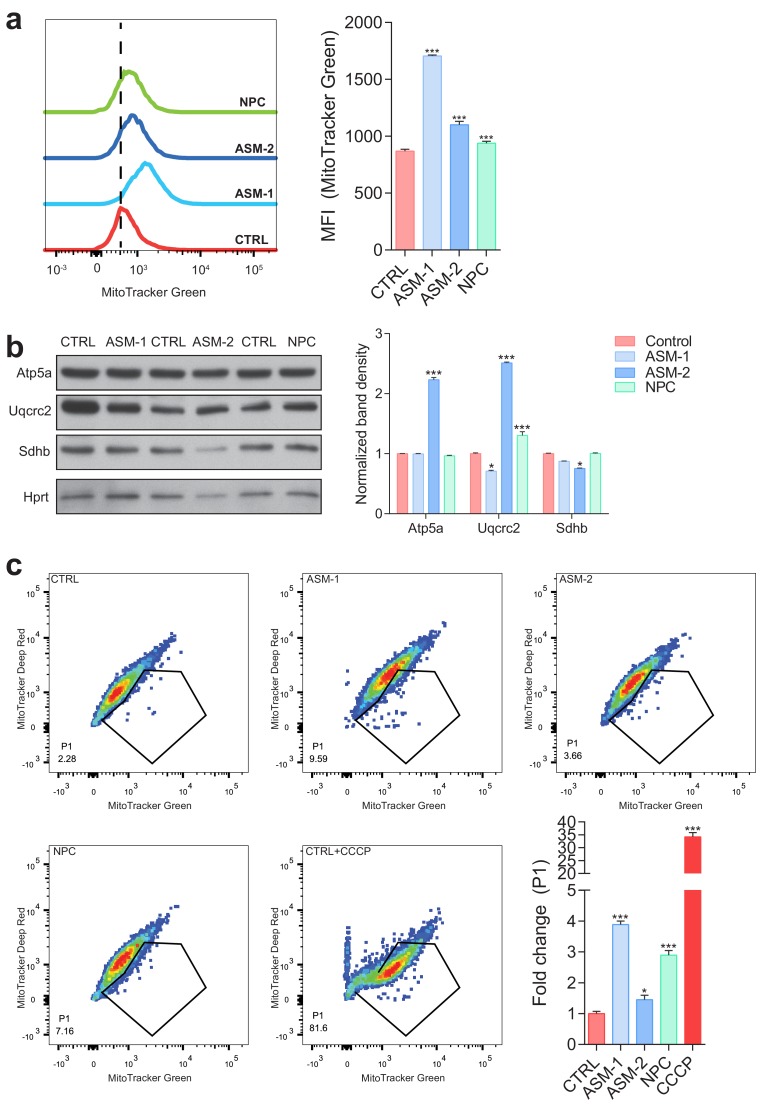
Increased content of dysfunctional mitochondria in ASM-deficient and NPC fibroblasts.(a) Mitochondrial mass was assessed by flow cytometry with MitoTracker Green staining. Histogram plot shows a right shift in intensity of MitoTracker Green dye in ASM and NPC patient cells relative to controls. Quantifications are depicted as mean fluorescent intensity (MFI) ± s.e.m., n = 5 with two technical replicates each. (b) Mitochondrial mass as assessed by western blot of mitochondrial protmean ± s.e.m., n = 3. T-test p-value *p<0.05, ***p<0.001. (c) Co-staining of MitoTracker Green and MitoTracker Deep Red dyes in ASM and NPC deficient fibroblasts showing increased population of dysfunctional mitochondria (MitoTracker Green positive and MitoTracker Deep Red negative population (P1) by flow cytometry). Quantification depicts fold change of P1 population shown as average ± s.e.m., n = 5 with two technical replicates.